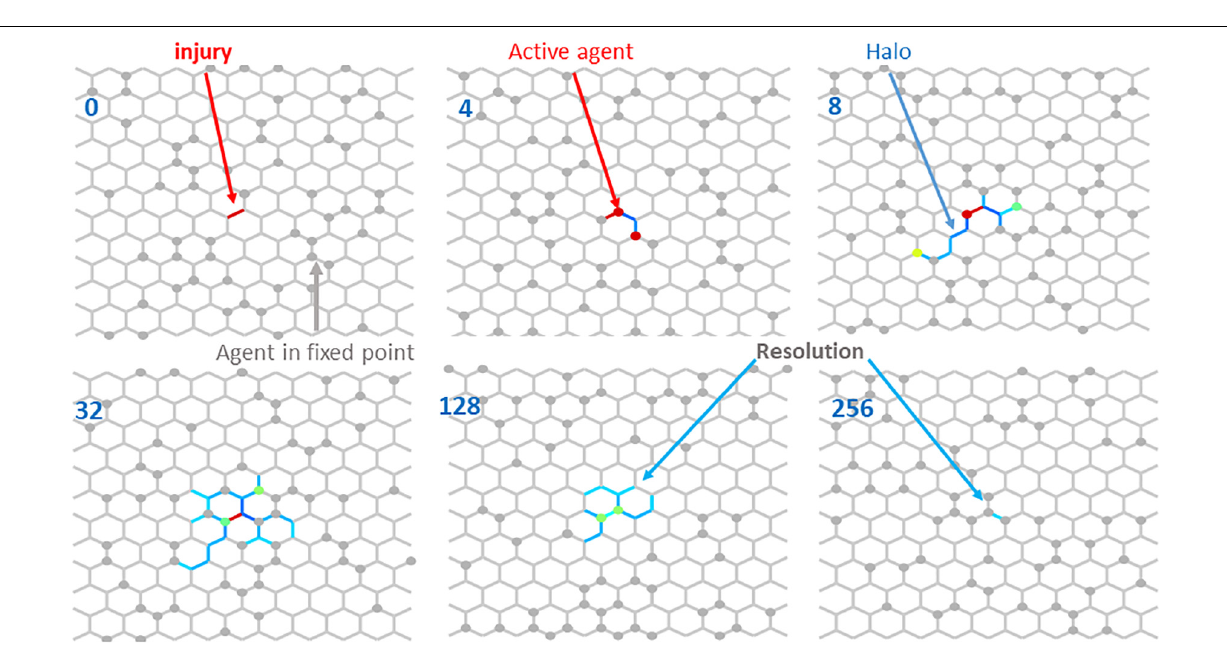
FIGURE 3 | Resolution of an injury modeled as a single spring with a high stiffness (red line element) at iteration time 0 indicated in the top left corner. As unactivated agents (gray circles) visit the injury site, they become active (red circles at time 4) and after stepping off the injury site, they also stiffen the neighborhood creating a halo (defined as the set of spring with stiffess 0.1% higher than the fixed point) around the original injury site (time 8). Notice a yellow, a green, a red and several gray agents on or around the halo. Over the course of more time steps, the halo first increases (time 32), then gradually shrinks (time 128) and at time 256 there is only one network member left with a stiffness slightly higher than the fixed point. Eventually all members reach the fixed point. Colors from blue to red denote increasing agent activity and member stiffness. Gray members and agents represent fixed point